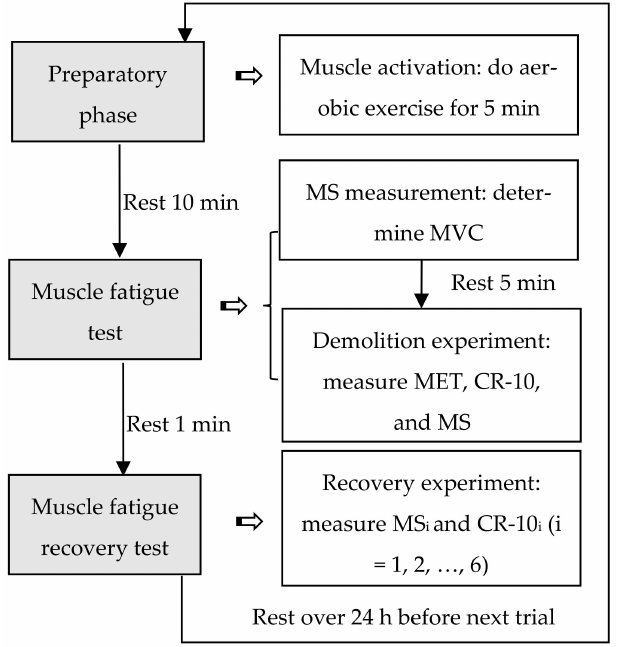
Figure 2. Experiment procedure: MS : muscle strength, MVC : maximum voluntary contraction, MET: maximum endurance time, CR-10: